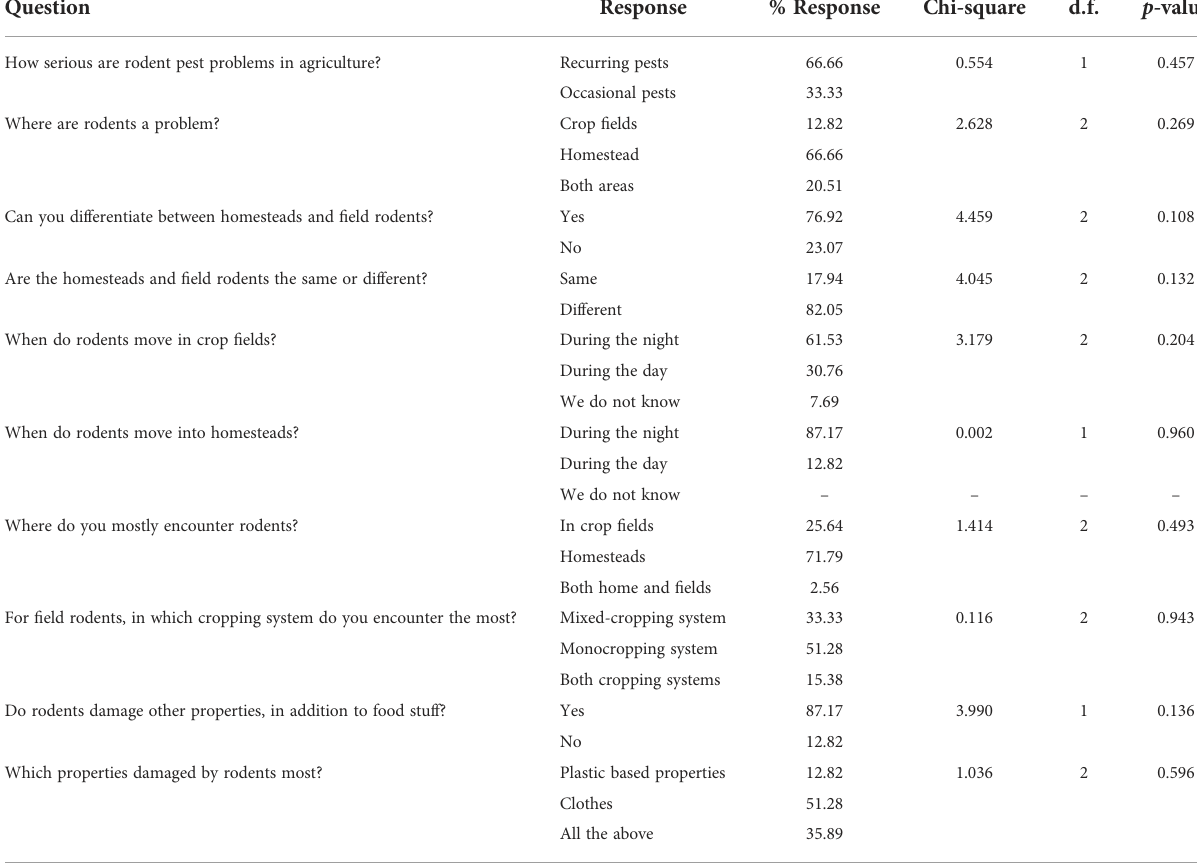
TABLE 2 Farmers ’ knowledge of rodent problems and the extent of the problem (n =